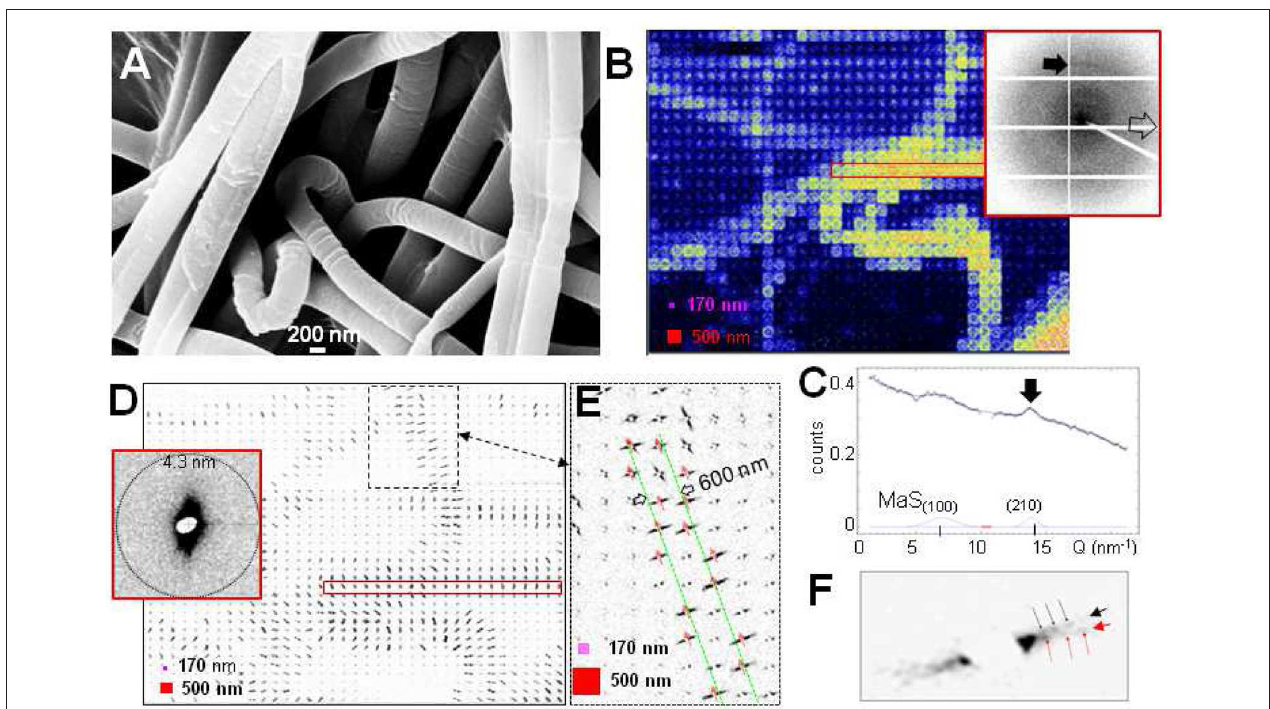
FIGURE 7 | Scanning nanoXRD of A. bruennichi’s decorating fibers with 500 nm hor × 500 nm ver raster-steps through a 170 nm hor × 170 nm ver focus. (A) Scanning electron microscopy (SEM) image of decorating fibers (Zeiss Leo SEM: 10 KV, 10nm sputtered gold layer). (B) WAXS composite image covering diffuse powder ring in inset-pattern; pink square: focus size; red square: step-increments (also in D,E ). Inset: averaged scattering from patterns within red, open rectangle. Black arrow indicates a weak equatorial peak; open arrow along local fiber axis. (C) Equatorial WAXS profile fitted by 2 Gaussians for Bragg peaks and a 1st-order polynomial for the overall diffuse scattering. Black arrow as for inset-pattern in (B) . MaS (100) / (210) positions: ( Riekel et al., 2017). (D) SAXS composite image based on equatorial streak. Inset shows averaged scattering from within red rectangle. (E) Zoom of dashed area in (D) ; SAXS streaks define the contours (in green) of an about 600nm diameter fiber (or thread); red arrows: local fiber axes. (F) Zoom into streak at rim of the fiber in (E) revealing two intensity-modulated streaks with ∼ 10 0 angular separation (black/red